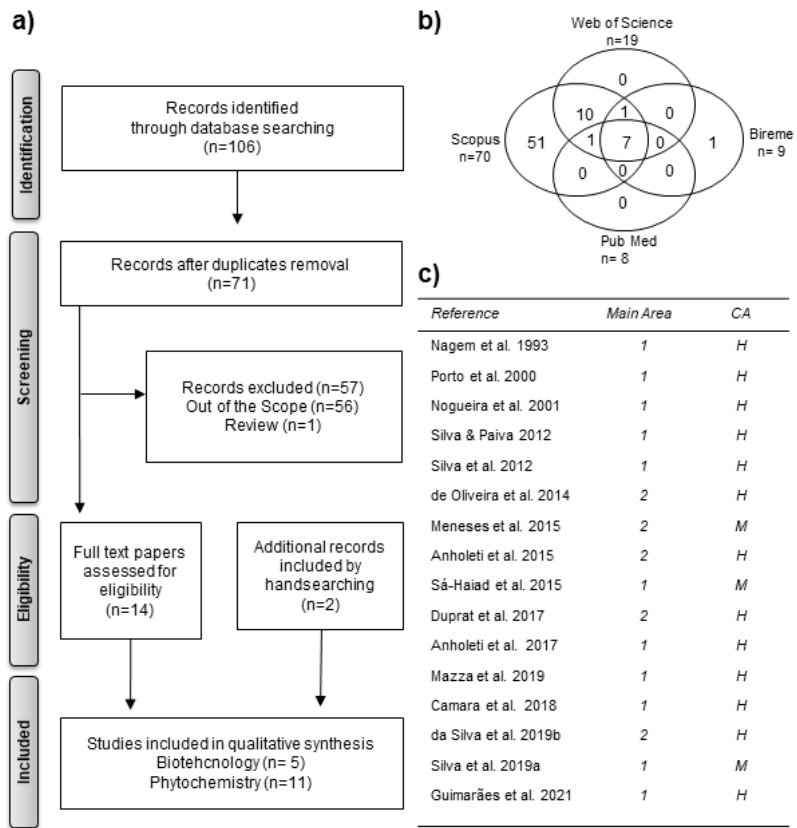
Figure 1. Flow diagram of literature search results and its critical appraisal. The